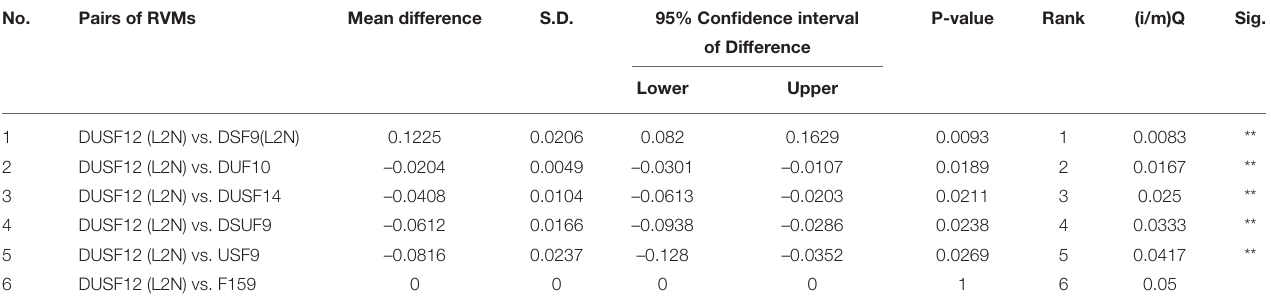
TABLE 7 | Paired sample t test of the difference in specificity between the best model with other models.